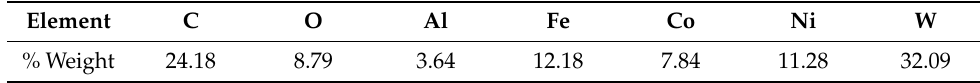
Table 5. Elemental composition of the red cross rectangular region in Figure 6.